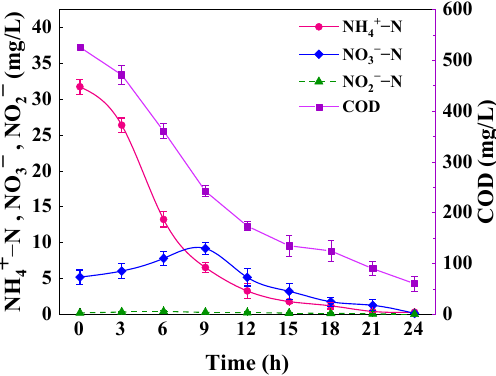
Figure 11. Treatment performance of simulated mariculture wastewater by Vibrio sp. LY1024.